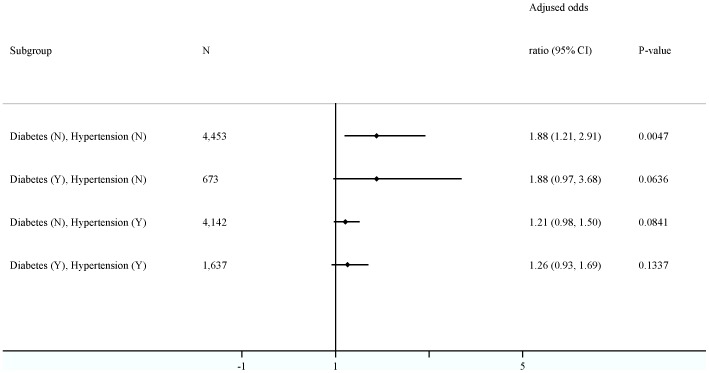
Subgroups analyses categorized by diabetes and hypertension in a 56-day case period of time window.